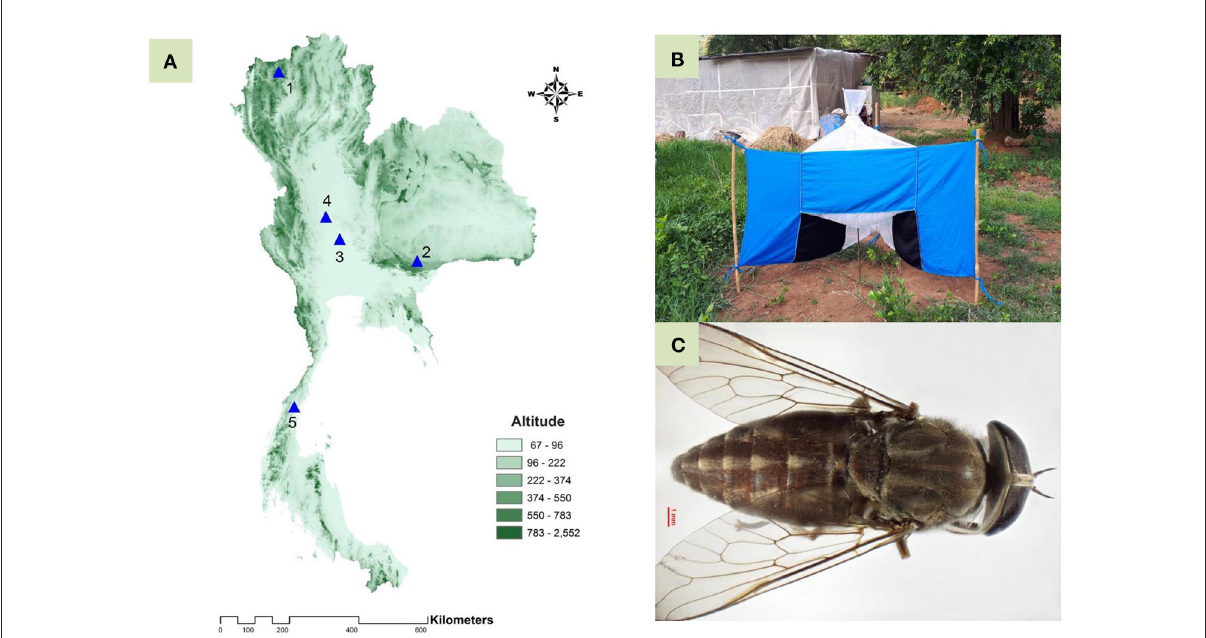
FIGURE1 Topographic map of Thailand showing five populations of Tabanus rubidus : 1, Chiang Mai; 2, Nakhon Ratchasima; 3, Uthai Thani; 4, Singburi; and 5, Chumphon (A) ; Nzi Trap used for collecting specimens from genus Tabanus (B) ; and adult T. rubidus female specimen (C) .